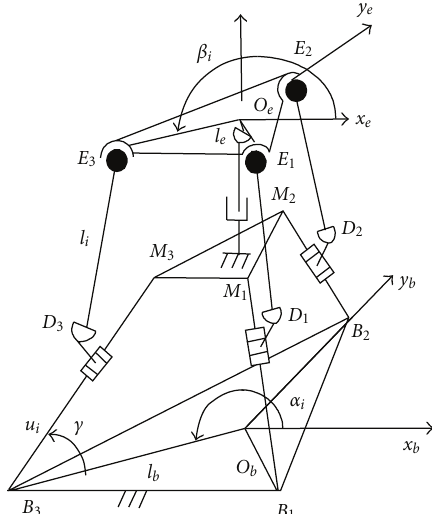
Figure 2: Parametric description of tripod-based PKM